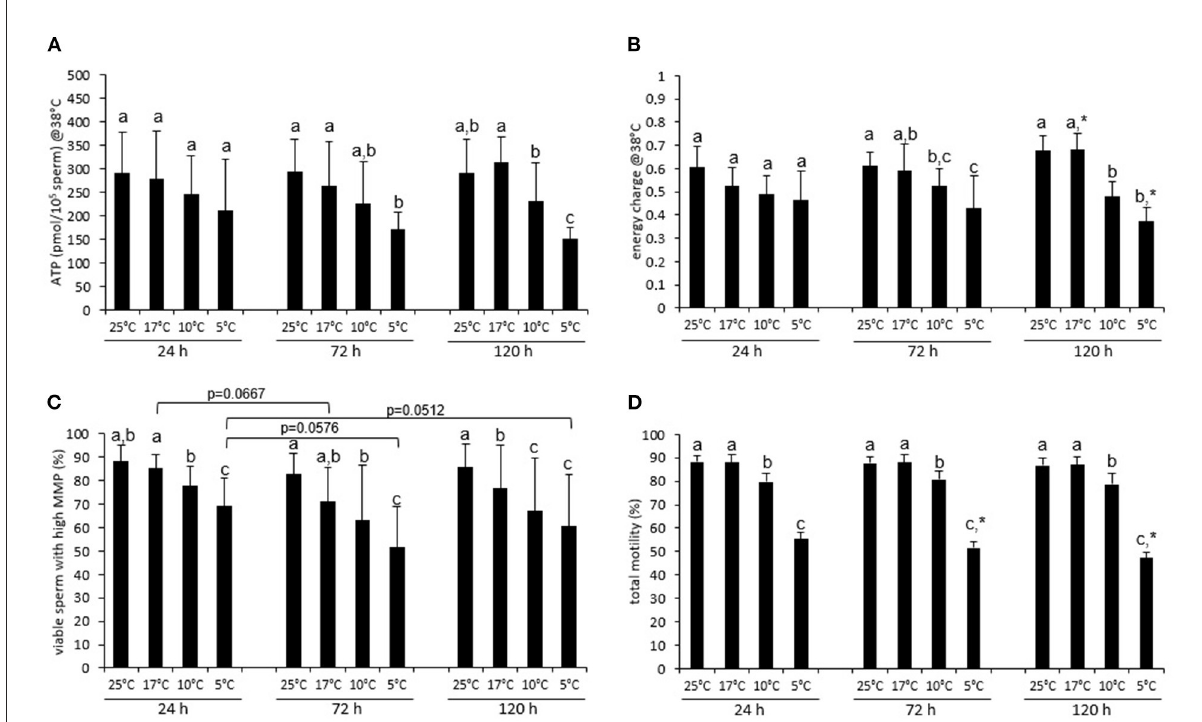
FIGURE2 Energy status, mitochondrial function and motility of stored spermatozoa after incubation at 38 ◦ C. ATP content (A) , energy charge (B) , percentage of viable sperm with high mitochondrial transmembrane potential [hMMP; (C) ], and total motility (D) after 30min incubation at 38 ◦ C for extended boar semen samples stored at various temperatures. Data are presented as means ± standard deviation ( n = 7 boars). (a–c) Different letters indicate significant differences between storage temperatures within a given day ( P < 0 .05). An asterisk ( * ) indicates a significant difference between values after 72 or 120h storage and the value after 24h storage ( P < 0.05). Values before incubation are presented in Figure